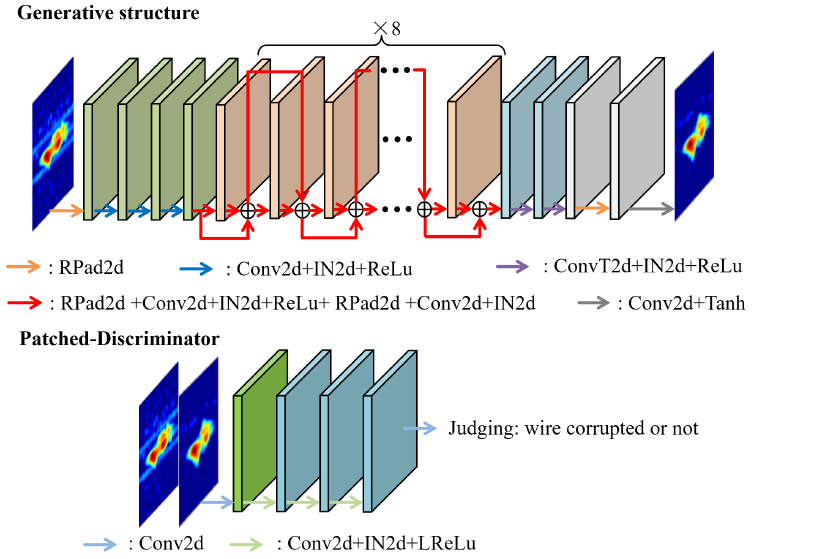
Figure 4. Generative and discriminative structures for the de-wiring Cycle GAN. The generator can achieve the spectrogram de-wiring task. The patched GAN is used as a discriminator. Only the de-wiring parts ( G f and D X ) are presented. The other parts ( G b and D Y ) share the same generative and discriminative